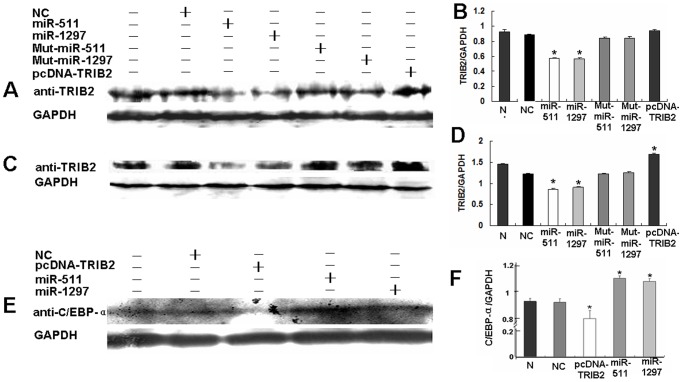
Detection of protein by western blotting.(A, B) lung adenocarcinoma A549 cells were treated with miRNAs and their controls, TRIB2 expression was detected and the results showed that its expression in the miR-511- and miR-1297-treated cultures was much lower than that of NC-(or mutation miRNA)-treated cultures (*p<0.01). Relative values for TRIB2 vs GAPDH are indicated to the right of the gel (Fig. 4B). (C, D) Another lung adenocarcinoma LTEP-a-2 cells were treated with miRNAs and their controls, TRIB2 expression was aso much lower in the miR-511- and miR-1297-treated cells than that of NC-(or mutation miRNA)-treated cultures (*p<0.01). Relative values for TRIB2 vs GAPDH are shown to the right of the gel (Fig. 4D). (E, F) C/EBPα expression was analyzed and the results showed that its expression was increased in the miR-511- and miR-1297-treated cells than that of the control cells (NC group, *p<0.05). Relative values for TRIB2 vs GAPDH are indicated to the right of the gel (Fig. 4F). N, negative control cells. NC, miR-511, miR-1297, mut-miR-511, mut-miR-1297, and pcDNA-TRIB2, cells treated with NC, miR-511, miR-1297, mut-miR-511, mut-miR-1297, and pcDNA-TRIB2 vector, respectively.